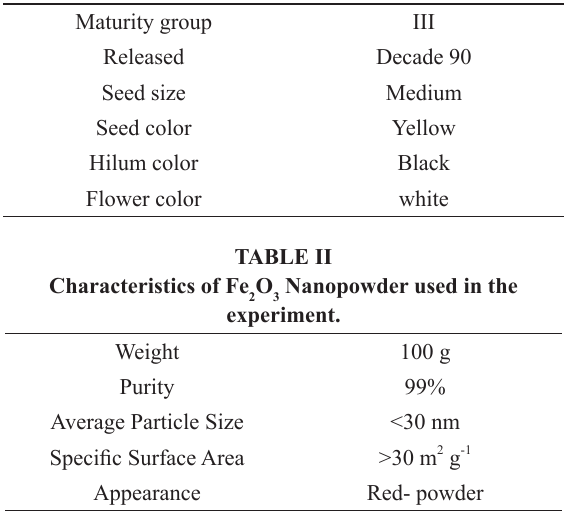
Characteristics of soybean cultivar (L17) which used in the experiment.